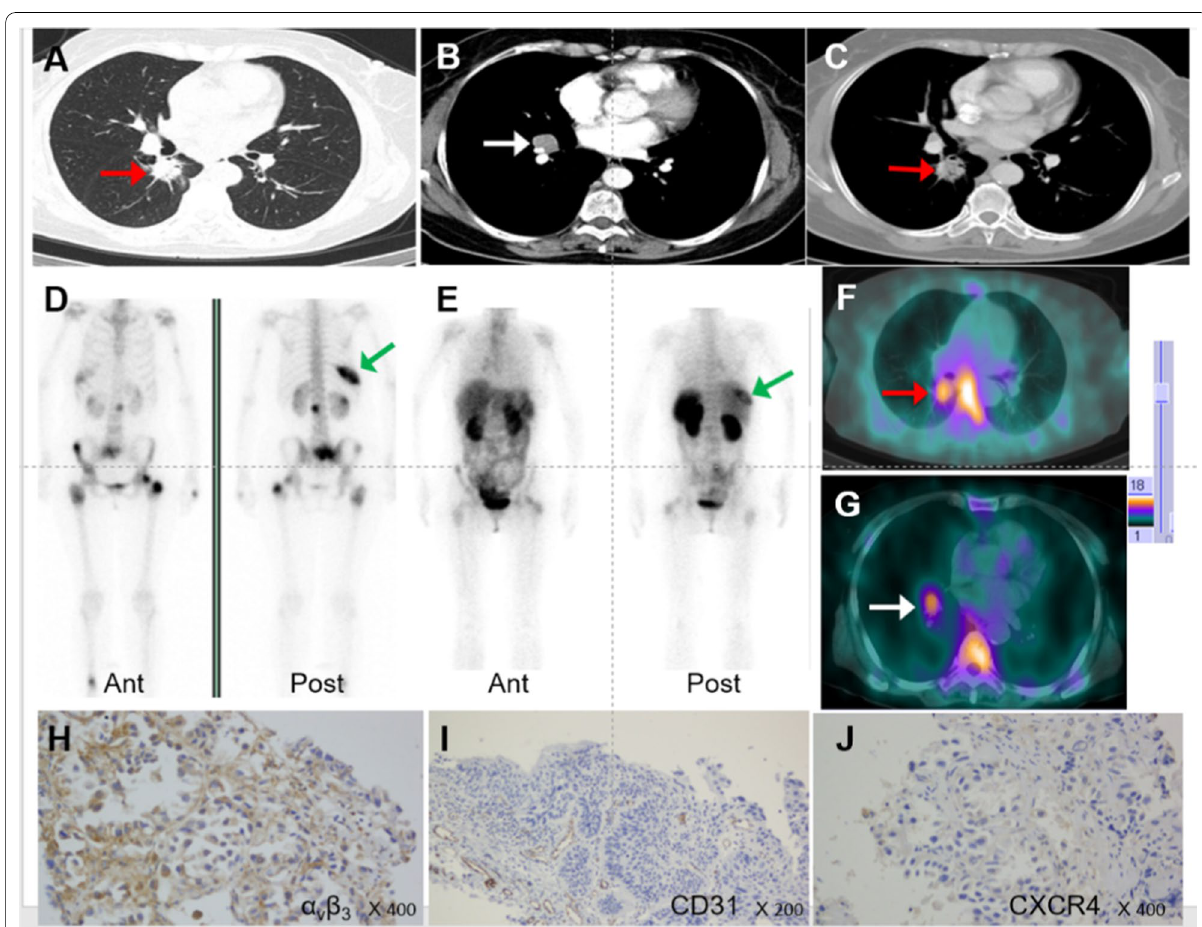
Fig. 2 [ 99m Tc]Tc-Galacto-RGD 2 imaging showed RGD-avid uptake in the primary tumour, lymphadenopathy, and remote metastases in a patient with suspected multiple myeloma. The final diagnosis was lung adenocarcinoma confirmed by bronchoscopic biopsy. a Primary lesion presented in the lung window. b , c Enhanced CT showed primary tumour and lymphadenopathy in the right hilum. d , e Bone scan showed lytic lesion in the right rib and sclerotic lesions in the pelvis. f , g 99m Tc-Galacto-RGD 2 image showed avid lesions in the right lung and the right hilum. h , i , j IHC staining. h α v β 3 expression. i CD31 expression in neo-vasculature. j CXCR4 expression in tumour tissue